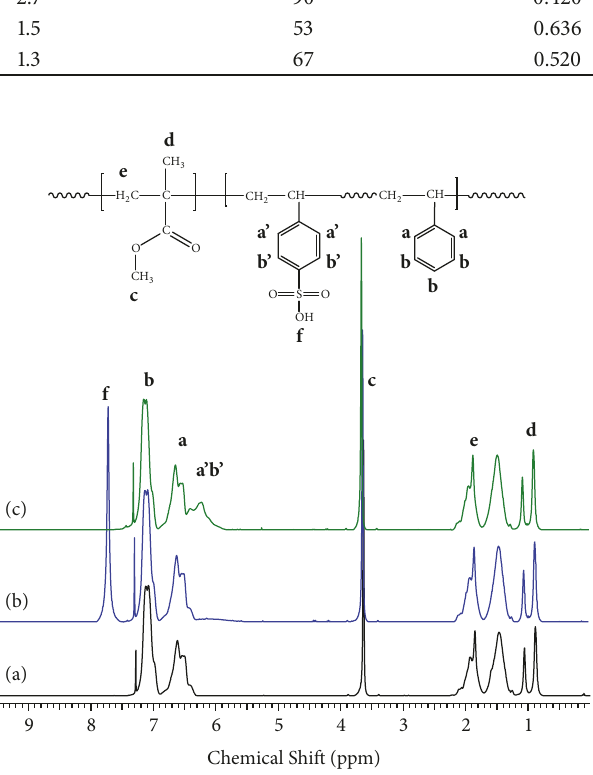
Figure 2: 1 H NMR spectra of PMMA- b -PS and PMMA- b -sPS BCs inCDCl 3 at27 ∘ C.(a)PMMA- b -PSBC:M3 60/40,(b)PMMA- b -sPS BC: M3 60/s40. (c) PMMA- b -sPS BC: M3 60/s40 in a CDCl 3 /D 2 O mixture at 27 ∘